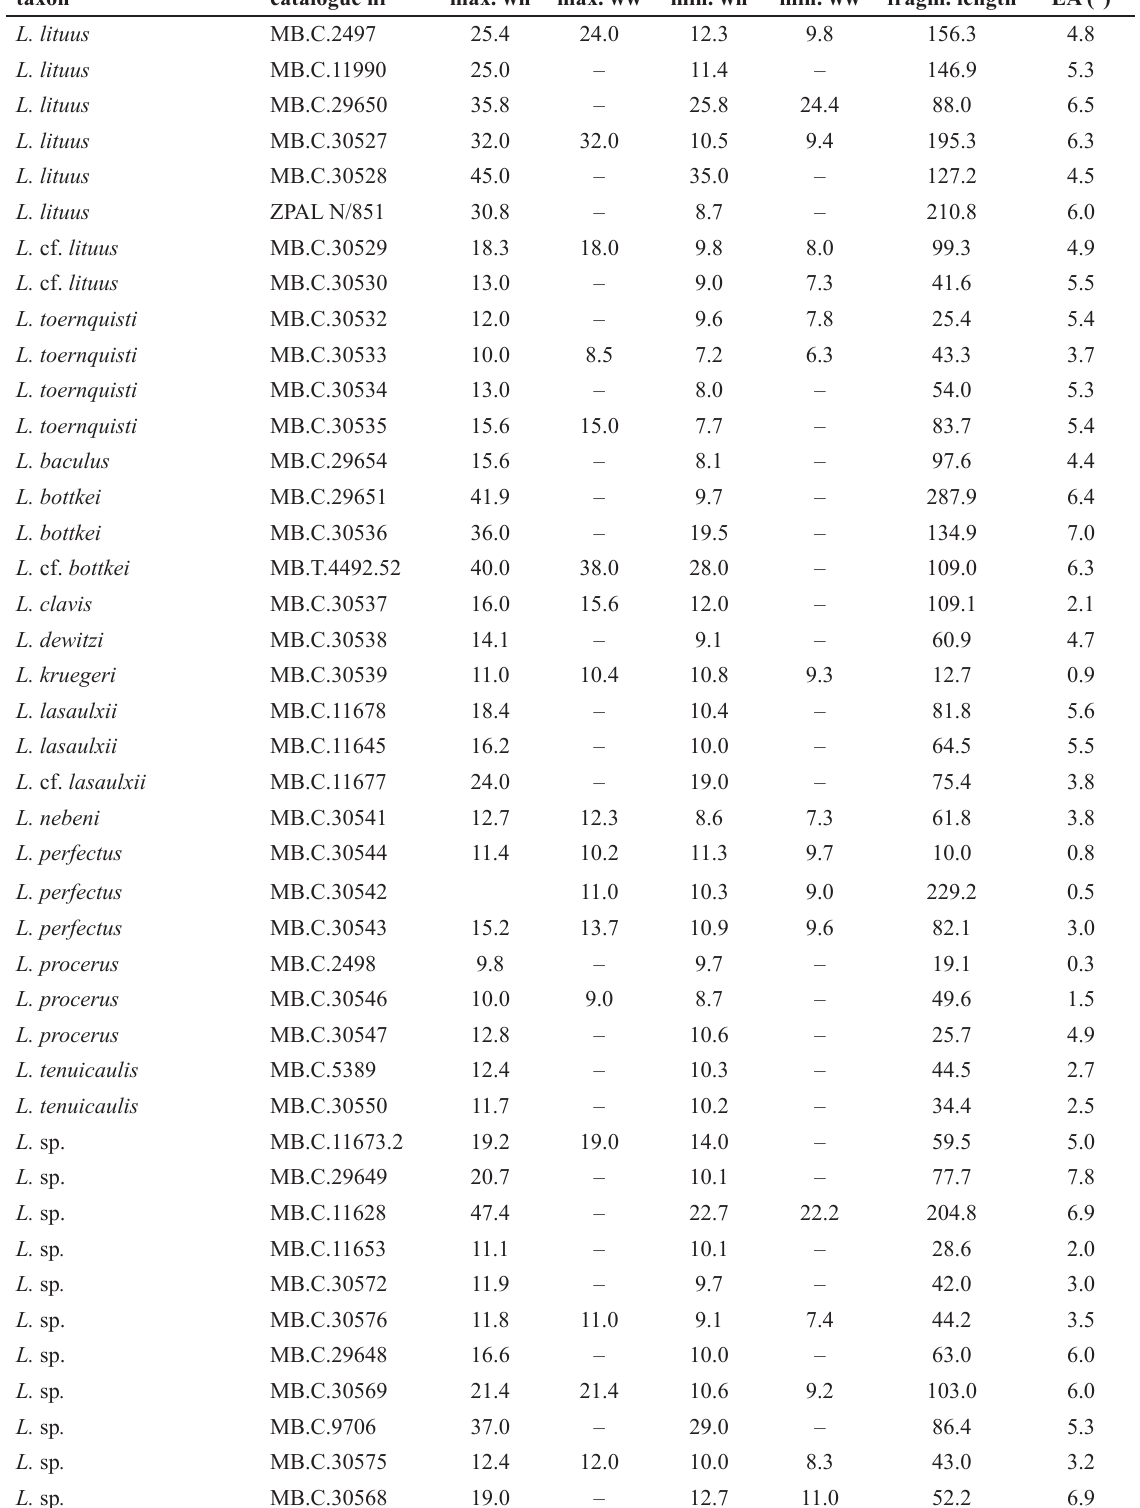
Table 10. Conch measurements (in mm), and expansion rates of uncoiled conch parts of Lituites Bertrand,